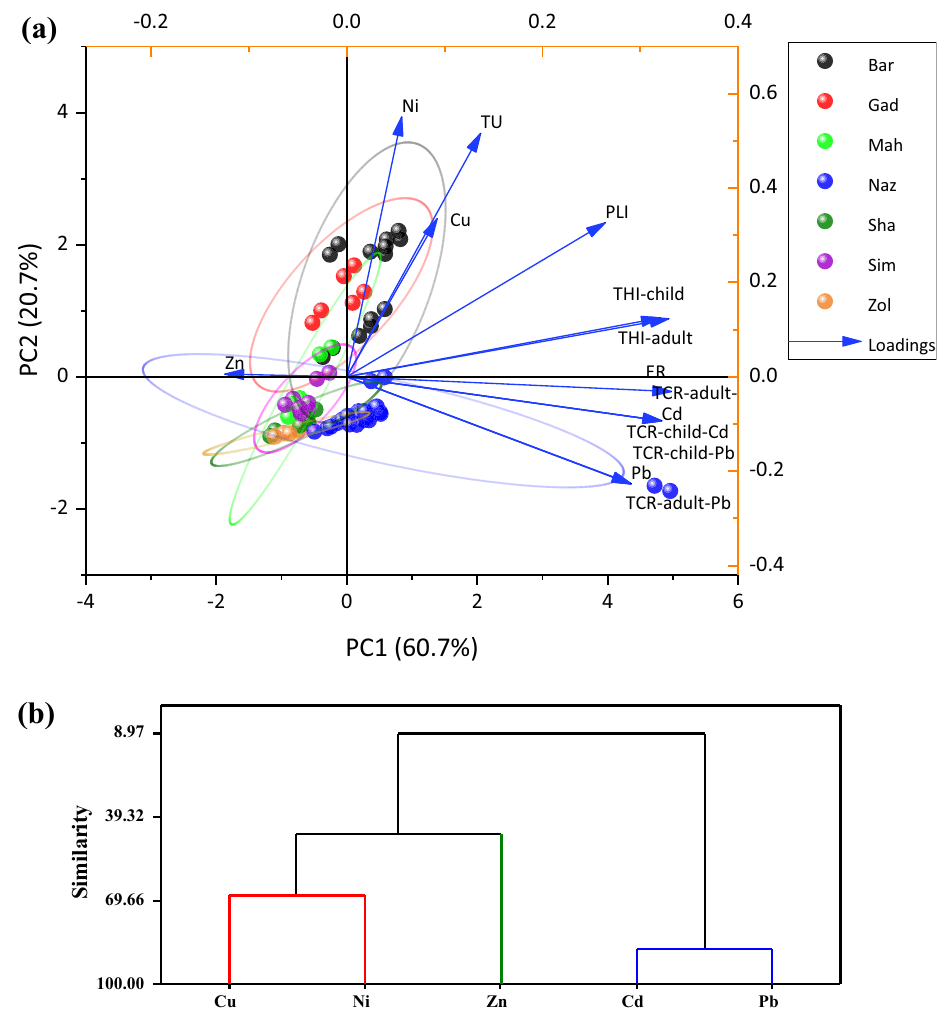
Figure 8. Biplot illustrates the PCA analysis ( a ) and dendrogram illustrates the hierarchical cluster analysis ( b ) of heavy metals in the sediment of the study rivers. Concentration ellipses around data points represent 95% confidence zone.